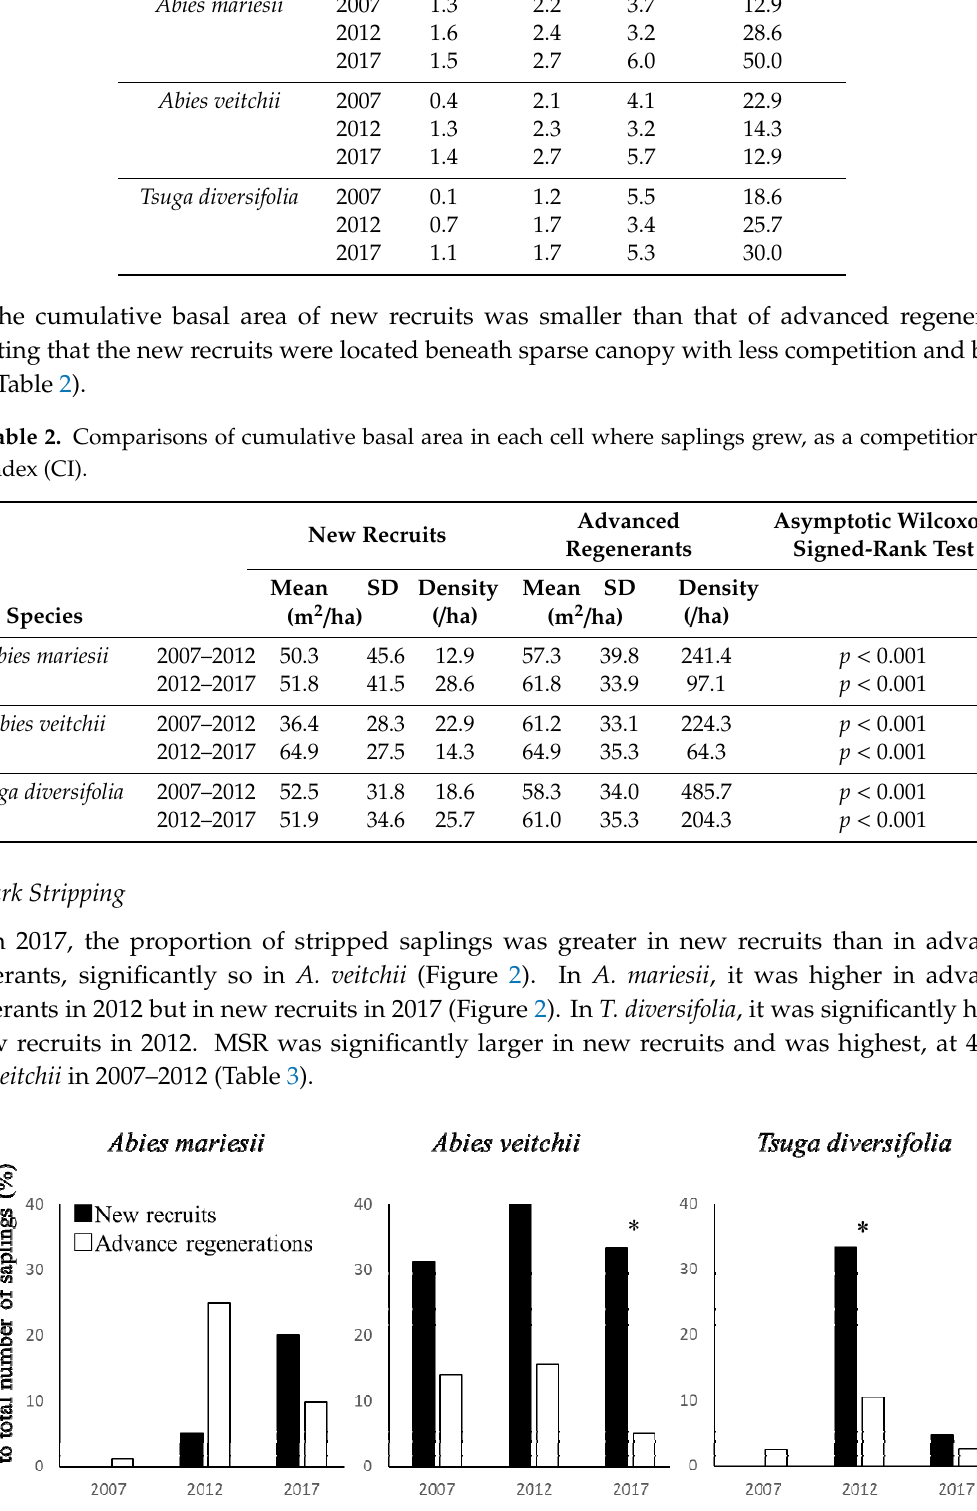
Figure 2. Ratios of number of stripped saplings to total number of saplings. *: p < 0.05. Table 3. Comparisons of maximum bark stripping ratio between new recruits and advanced regenerants (%).